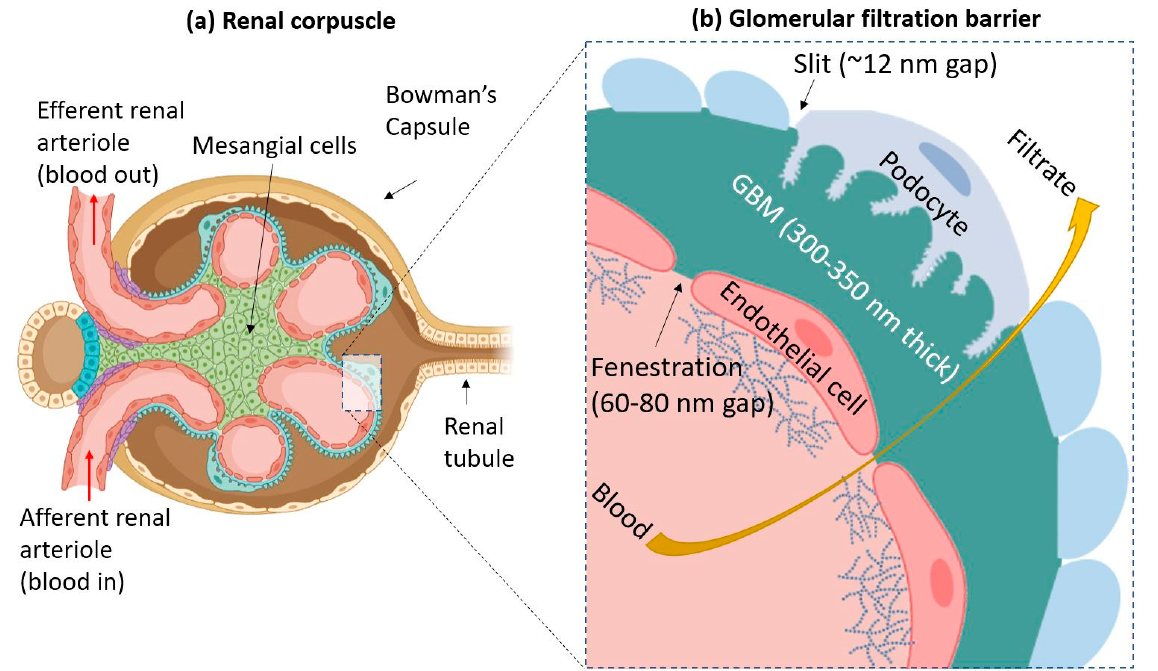
Figure 2. ( a ) A simplified diagram of the renal corpuscle. Blood flows into a glomerulus from the afferent renal arteriole. The filtered blood goes out through the efferent arteriole. Mesangial cells form the center of the corpuscle and hold the glomerulus together. ( b ) The three components of the glomerular filtration barrier (GFB) are endothelial cells (which have a surface covered by glycocalyx), the glomerular basement membrane (GBM), and podocytes. Blood from the glomerular capillary is filtered through these three layers, and the filtrate escapes out into the urinary space of Bowman’s capsule, as indicated by the yellow arrow. The GFB typically prevents particles larger than 6–8 nm in size from passing through.